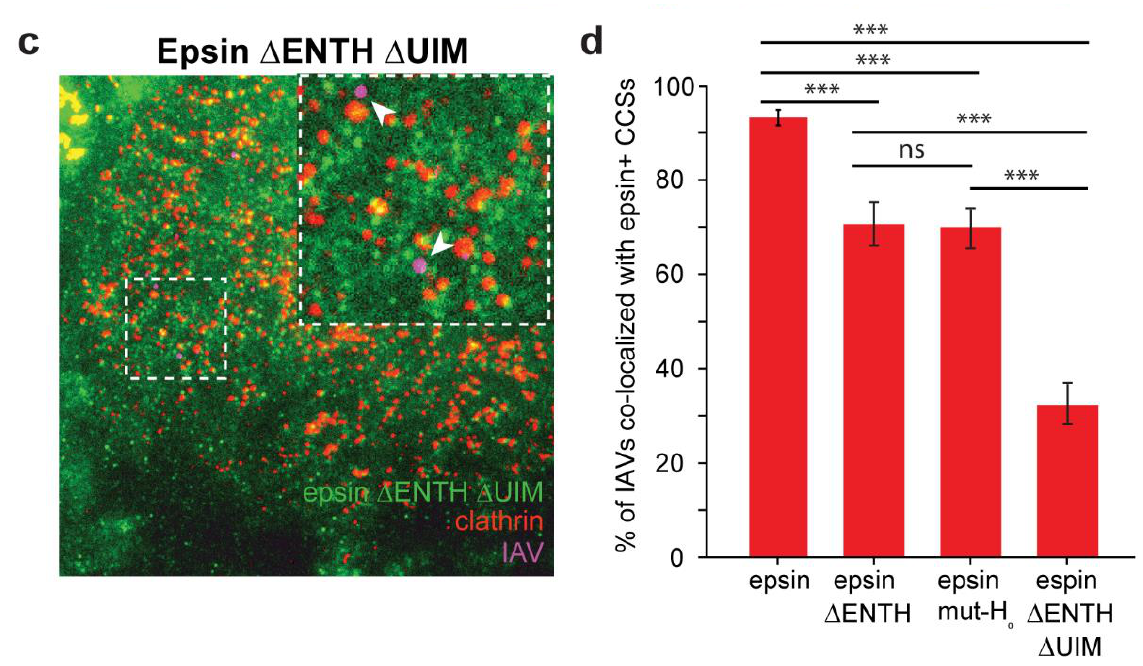
Figure 2. Colocalization to IAVs to CCSs is disrupted in cells overexpressing epsin without a functioning ENTH domain. ( a – c ) IAVs bound to surface of RPE cells stably expressing epsin ∆ ENTH EGFP, epsin mut-H 0 EGFP, epsin ∆ ENTH ∆ UIM EGFP and mCherry Clc, respectively. White arrows in inset show IAVs bound to the cell surface. (d) Fraction of IAVs colocalized with CCSs containing epsin mutants. For ( d ), N cells expressing epsin-EGFP, epsin ∆ ENTH EGFP, epsin mut-H 0 EGFP, epsin ∆ ENTH ∆ UIM EGFP were 15, 15, 15, 15, respectively. N IAVS analyzed for epsin-EGFP, epsin ΔENTH EGFP, epsin mut -H 0 EGFP, epsin ΔENTH ΔUIM EGFP were 288, 120, 147, 129 , respectively. For b the error bars denote standard error from binomial distribution. The data for epsin-EGFP is reproduced from Figure 1c. The error bars denote counting error from binomial distribution. ns and *** represent not significant and p < 0.001 respectively.